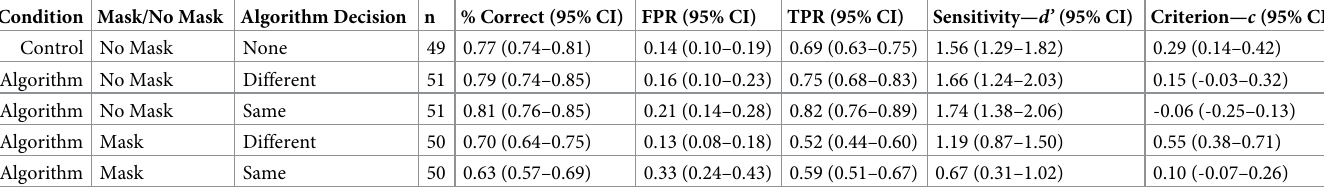
Table 1. Face matching performance as a function of test condition for Study 1 (threshold = 0.5). Condition Mask/No Mask Algorithm Decision